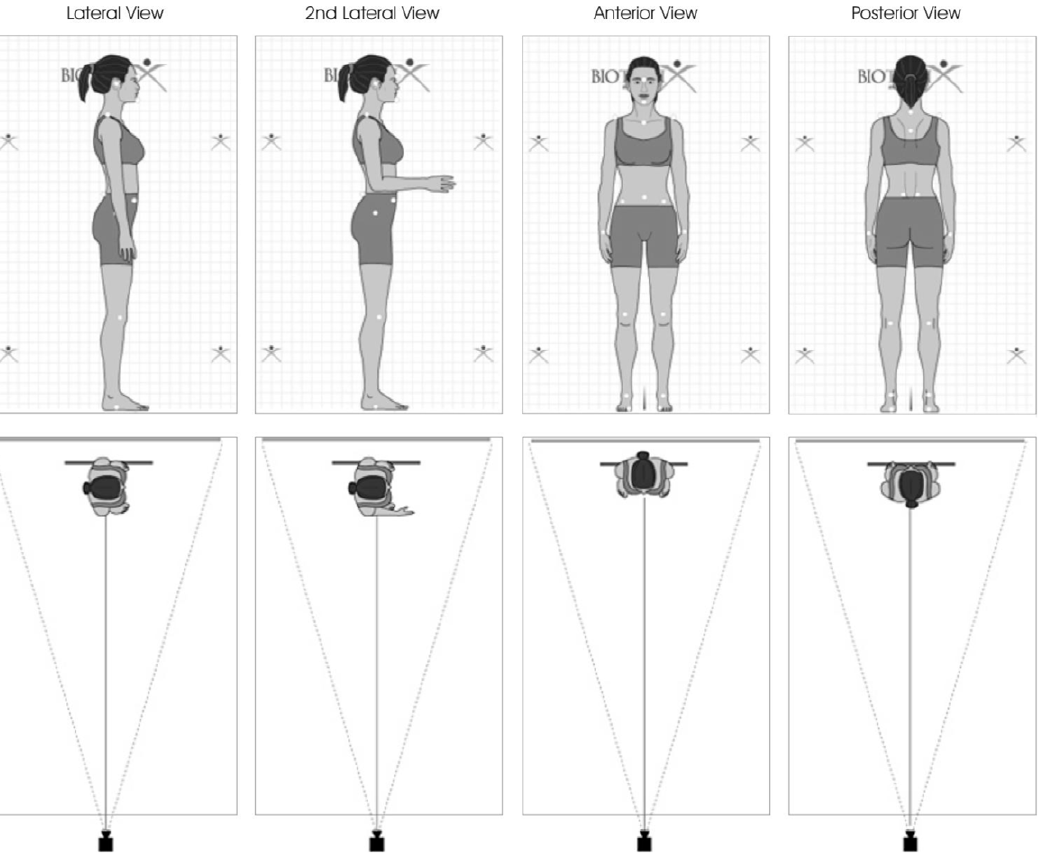
Figure 5. Relative position of subject and digital camera for the Biotonix platform evaluation. Four images were obtained per subject as shown; two lateral views, 1 anterior and one posterior using a digital camera on a tripod at a distance of 9 feet from a calibrated